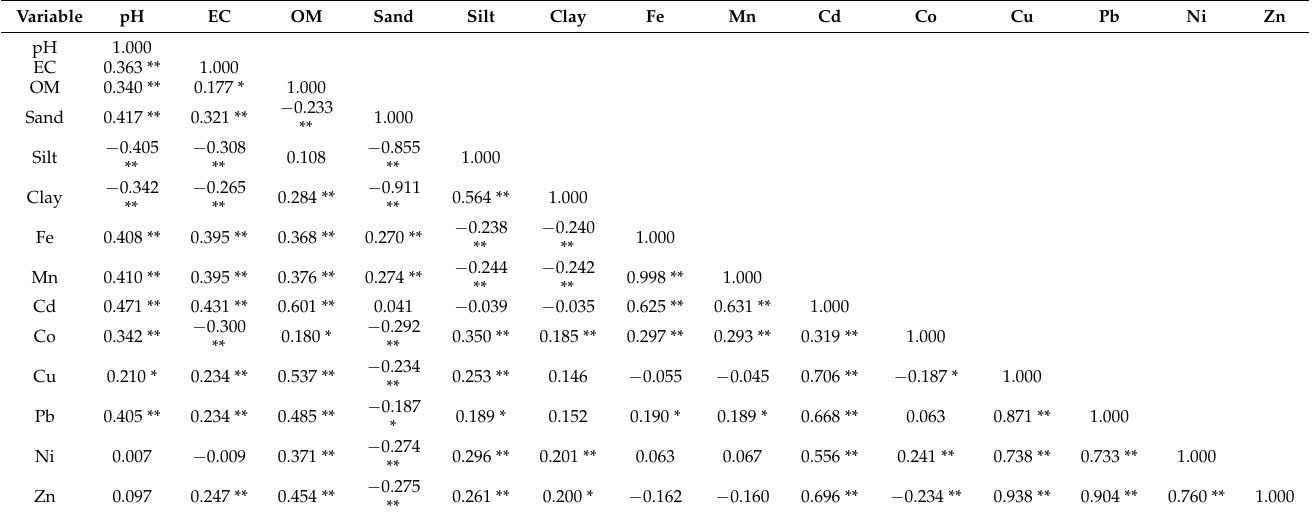
Table 2. Pearson’s correlation matrix between metals and soil properties ( n = 211).